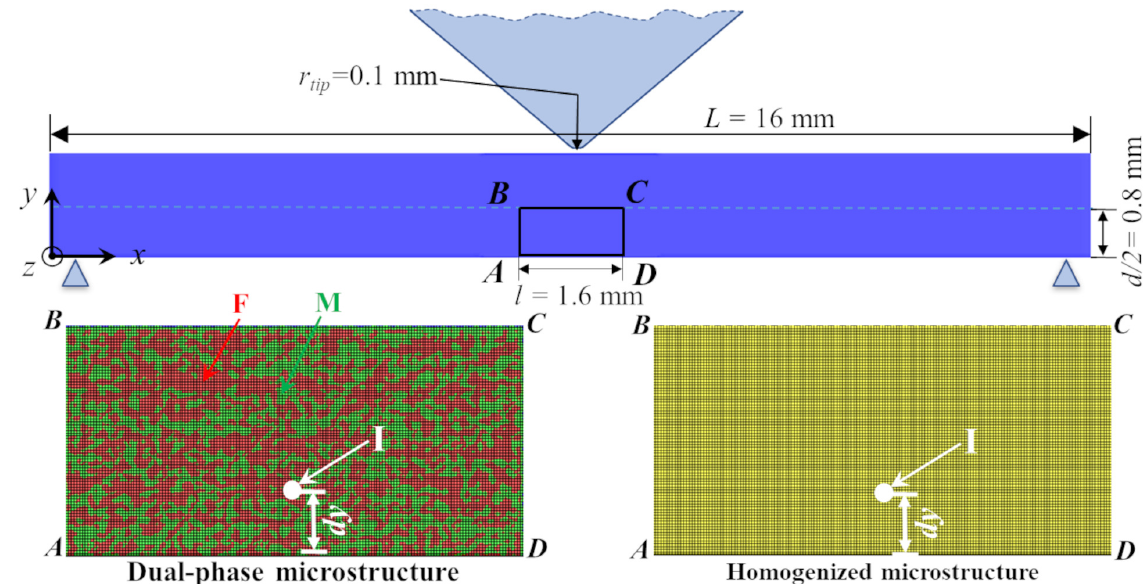
Figure 2. ( top ) A schematic of the bend specimen together with imposed constraint and loading conditions. ( bottom left ) A zoomed view of the finite element mesh near the free surface of the bend specimen of a dual-phase steel showing the discretely modeled ferrite (F) and martensite (M) phases, and an inclusion (I). ( bottom right ) A zoomed view of the finite element mesh near the free surface of the bend specimen of a single-phase material with an inclusion